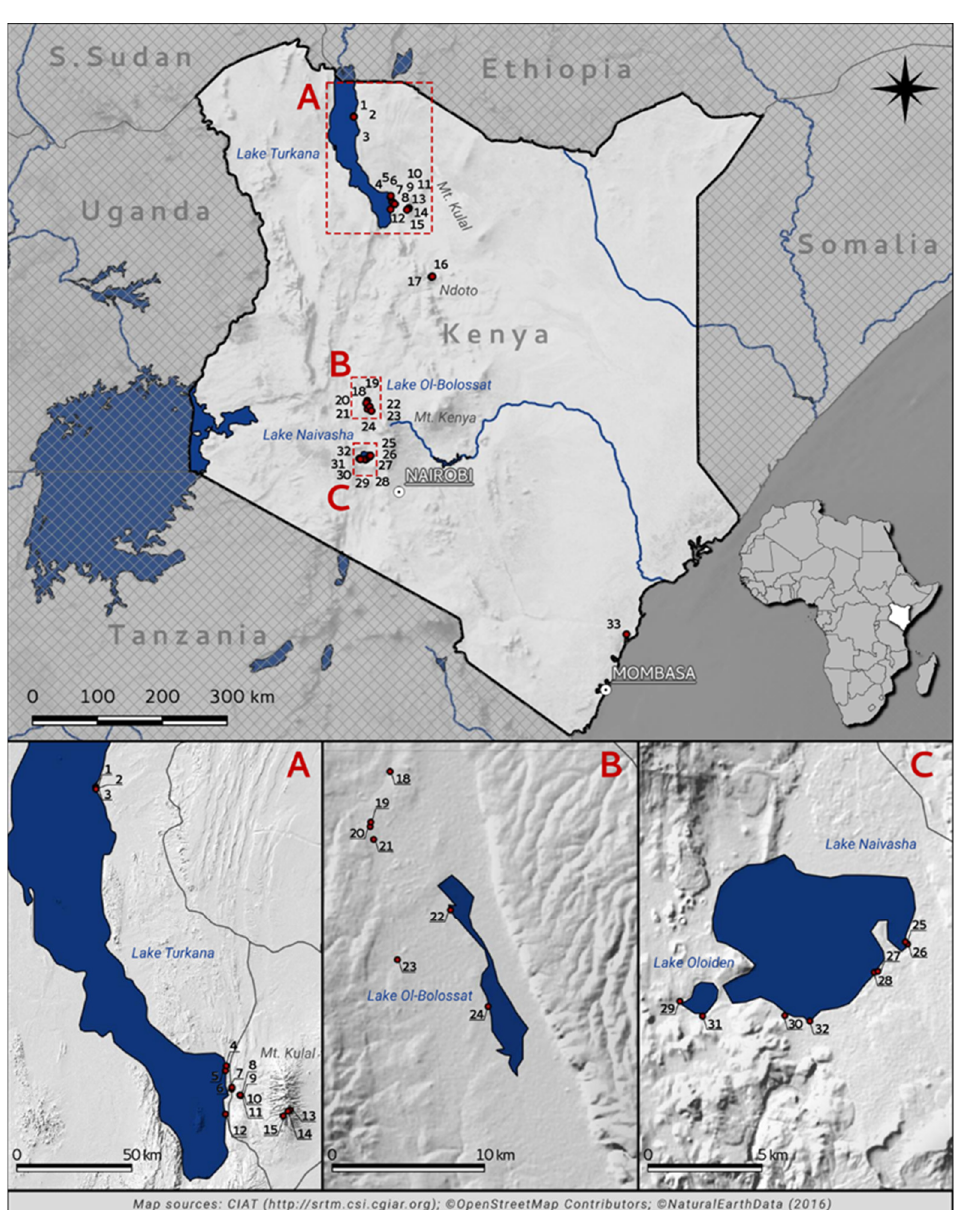
Figure 1. Location of the studied waterbodies in Kenya, with a close ‐ up of four large lakes (( A ) Lake Turkana, ( B ) Lake Ol ′ Bolossat, ( C ) Lake Naivasha and Lake Oloiden) (source data available in Jarvis et al. [87]). For a key to numbered sites, see Table 1. Table 1. List of the 33 sampled sites from 23 Kenyan waterbodies and their main environmental features. Sites ordered as in map (Figure 1). Temp = temperature; Sal. = salinity; artif. = artificial; d. = downstream; t. Mediterranean = temperate Mediterranean.